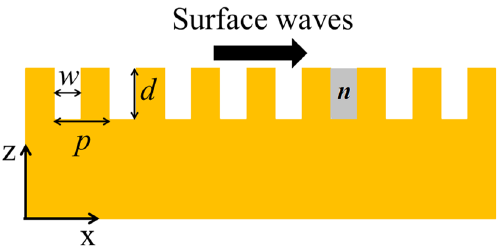
Figure 1. Schematic of metal grating showing width ( w ), period ( p ), depth ( d ), and refractive index ( n ) of the material filling in the single grey groove. The surface waves propagate along the direction of the X axis as shown by the black arrow.